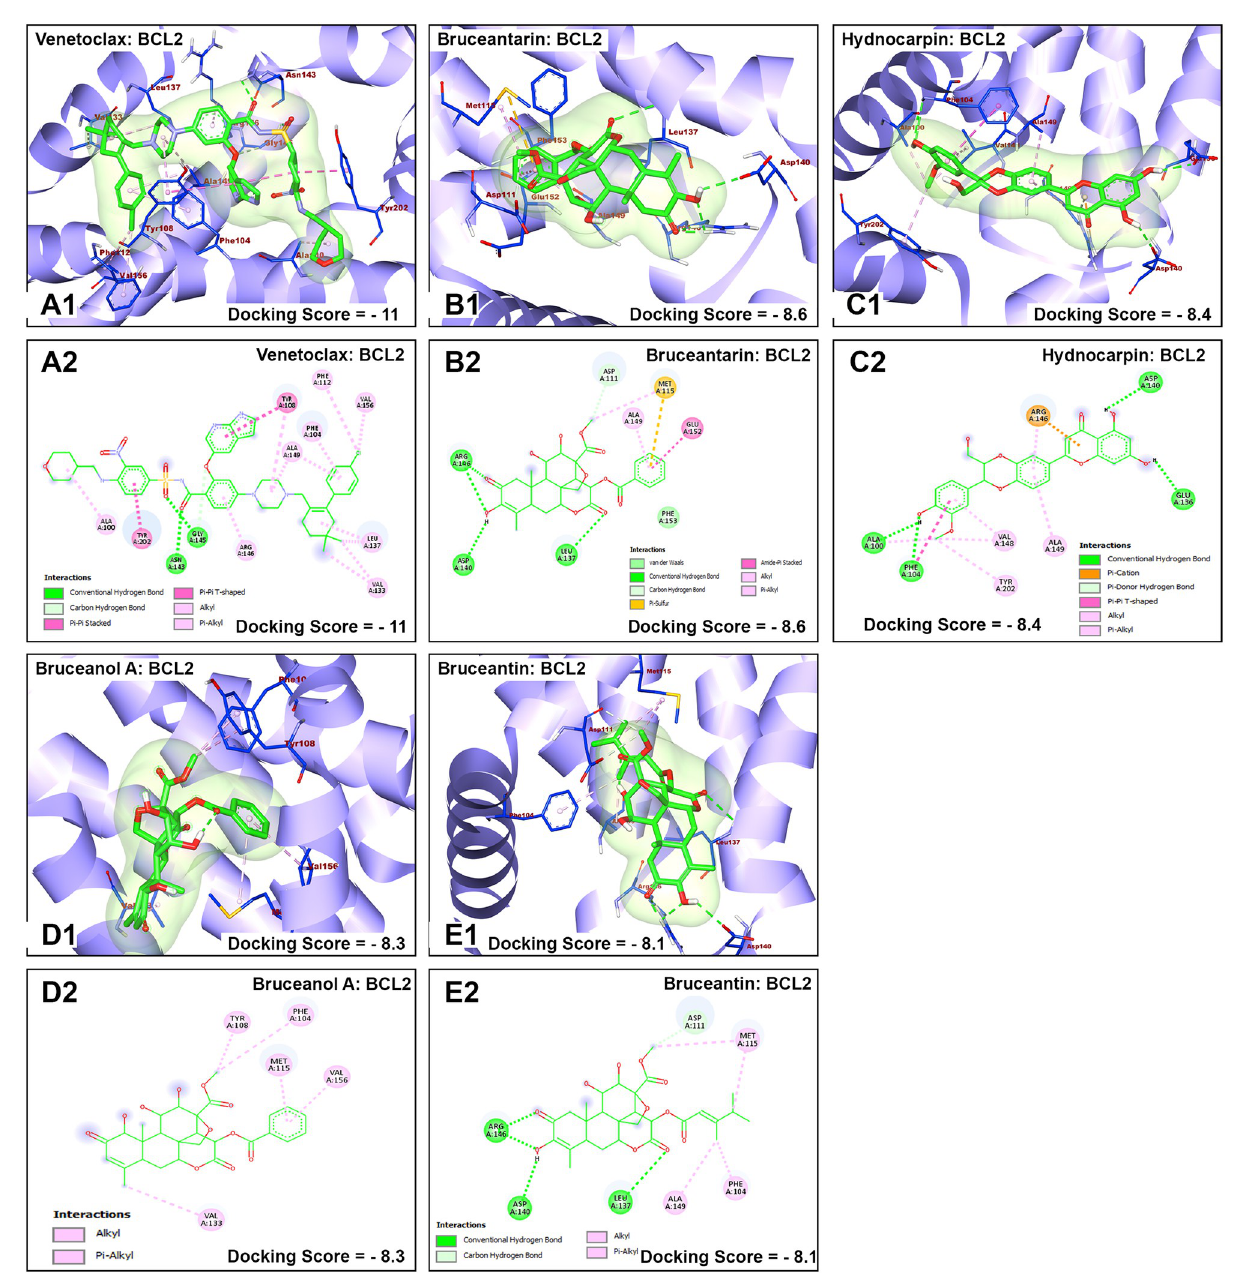
Fig 7. Molecular docking analysis of venetoclax and selected B . antidysentrica phytochemicals against BCL2 AML receptor. (1) 3D pose views of interaction of compounds with AML receptor FLT3. (2) 2D pose views of interaction of compounds with AML receptor BCL2.